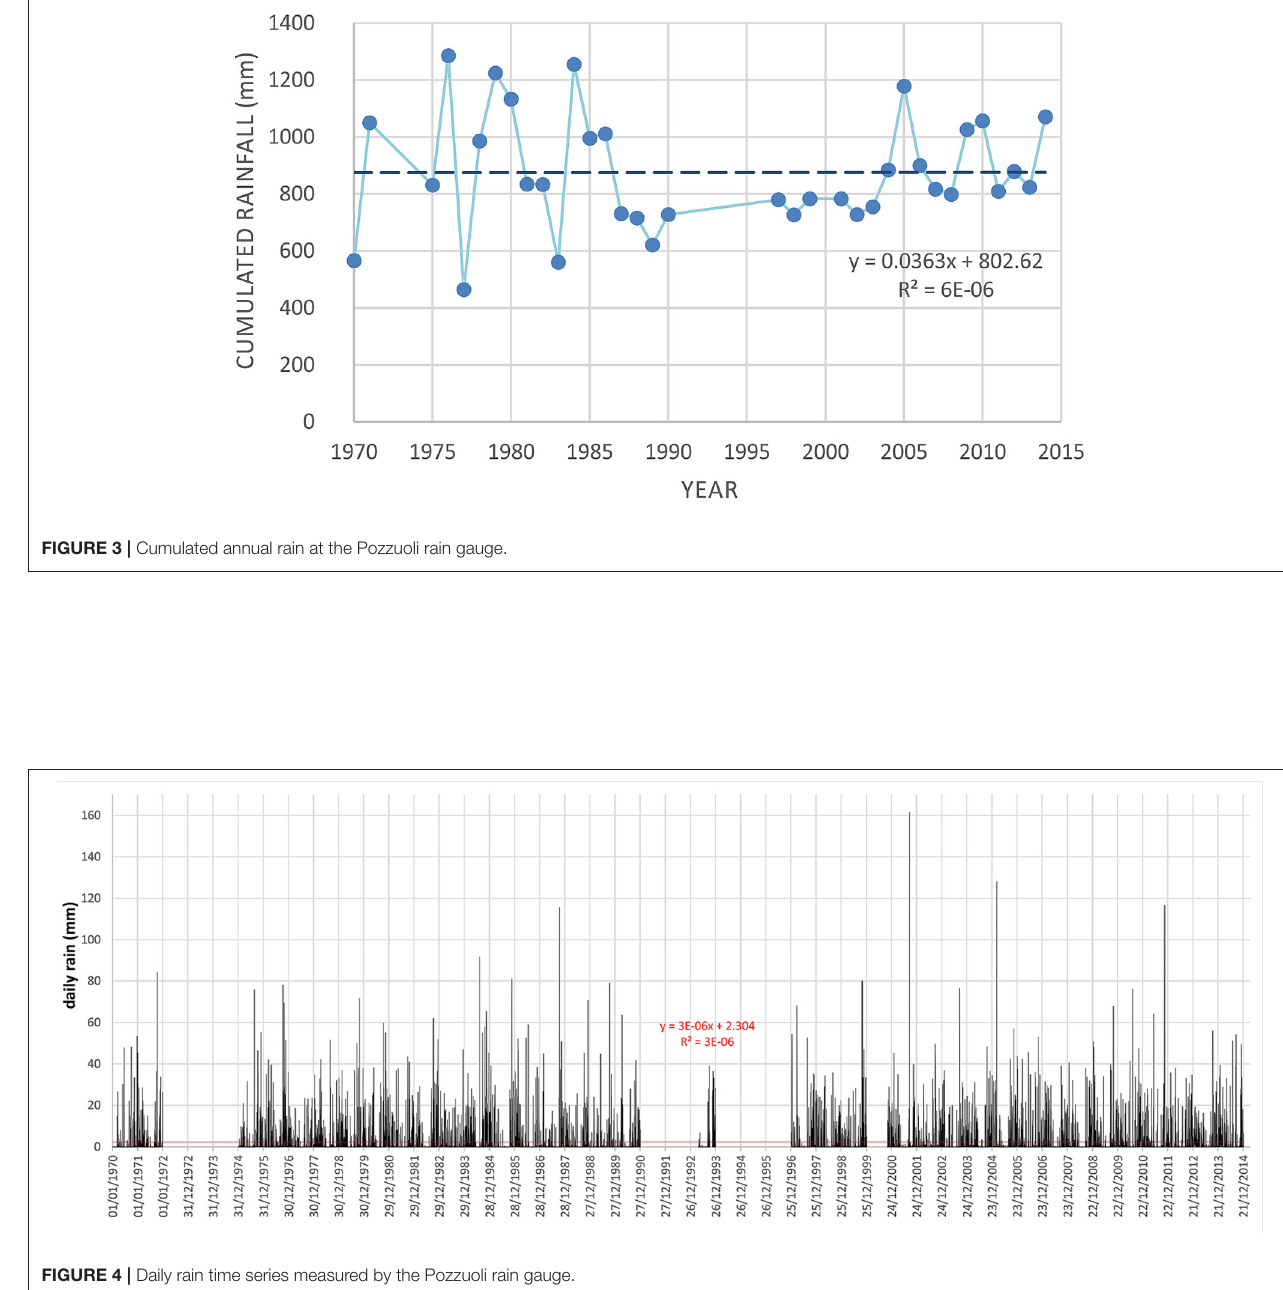
FIGURE 4 | Daily rain time series measured by the Pozzuoli rain